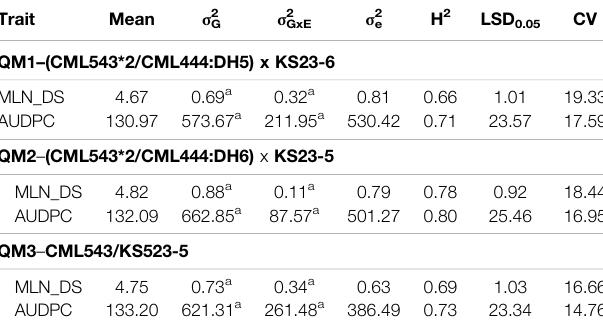
TABLE 2 | Means, variance, and heritability estimates for MLN resistance in the three F 3 populations used for linkage